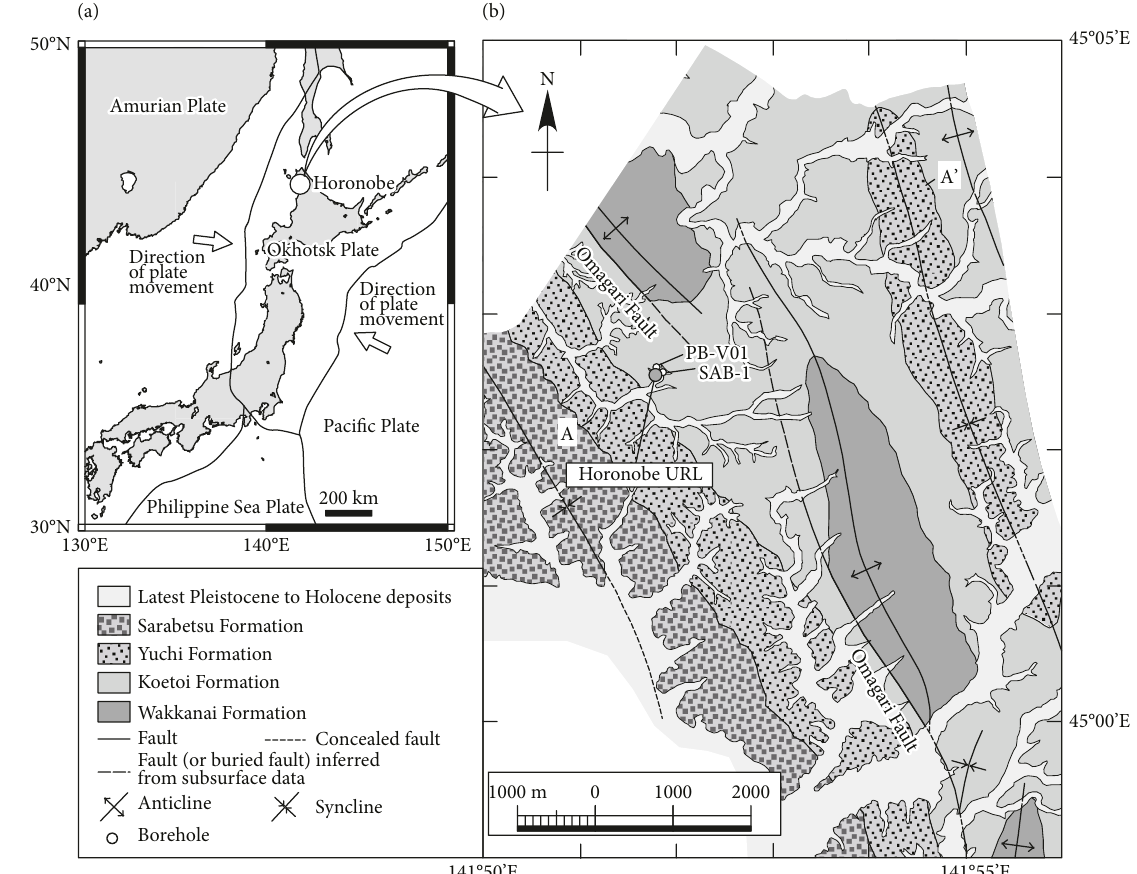
Figure 2: Maps showing the location of the Horonobe URL site and the boreholes: (a) location map and (b) geological map (after [51]). The plate boundaries and the direction of plate movement in (a) are from Wei and Seno